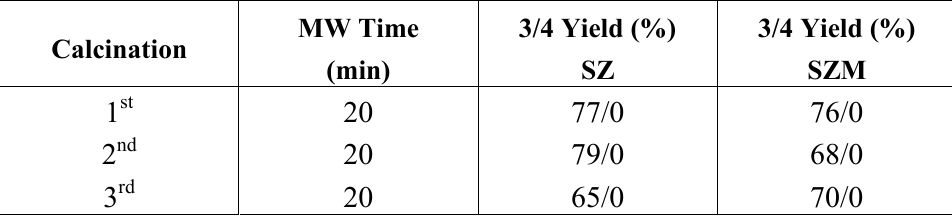
Table 3. Catalytic activity of reactivated catalysts. (3/4 yield refers to Scheme